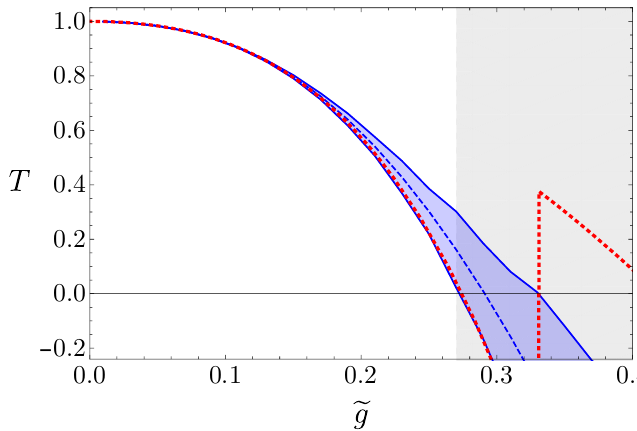
Figure 8 . The quantity T = ( coupled branch using the coe(cid:14)cients up to the using conformal mapping (blue dashed line) with optimal truncation (red dotted line). Note how the perturbative series gives a reliable result all the way up to